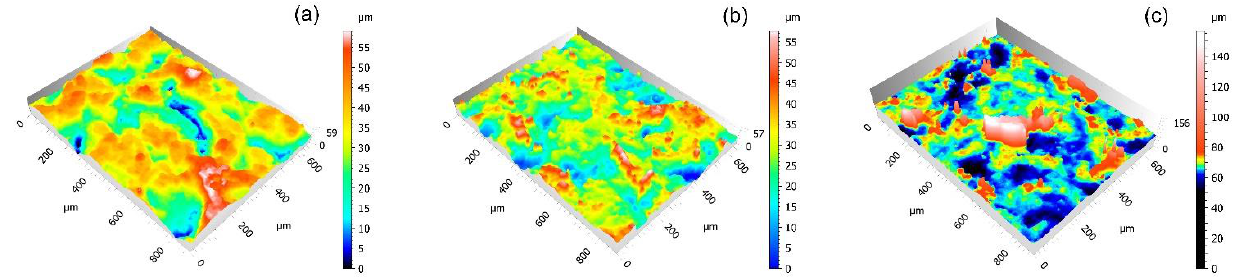
Figure 11. 2D images of the coatings after wear process of 4 s by the projection of plastic-polymer at 0.4 MPa, obtained with Leica DVM6 confocal microscope: ( a ) PFA, ( b ) FEP, and ( c ) PTFE.